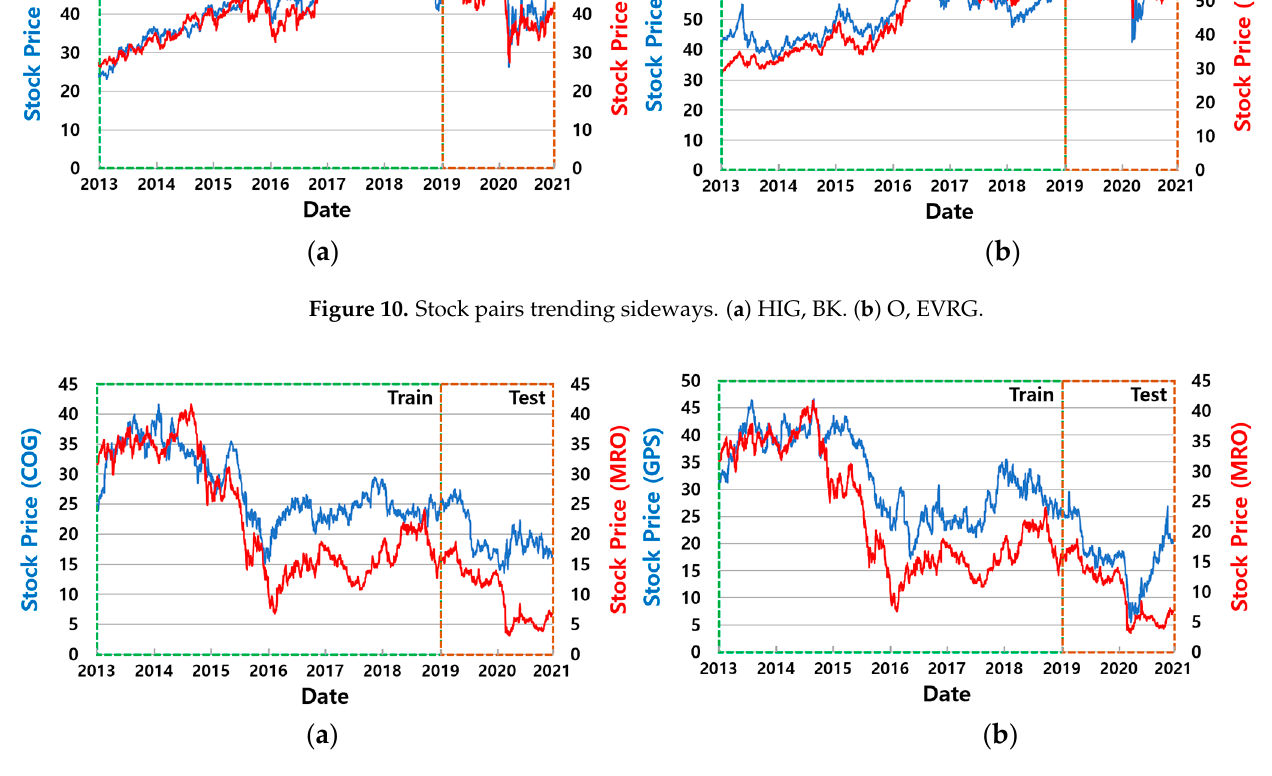
Figure 11. Stock pairs trending downward. ( a ) COG, MRO. ( b ) GPS, MRO.